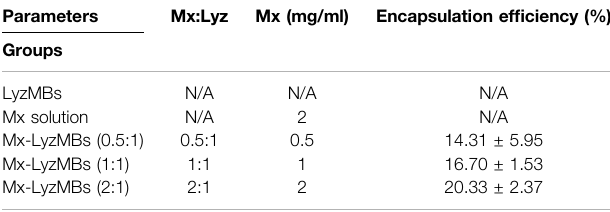
TABLE 1 | Composition and Mx encapsulation ef fi ciency of various LyzMBs.